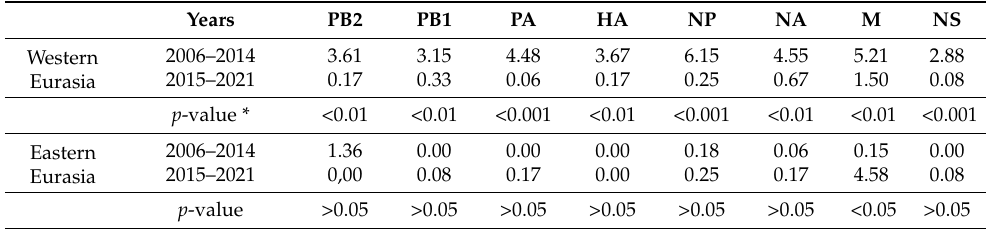
Table 2. Average number of viruses from Western and Eastern Eurasia closely related to each of the Moscow isolates for 2006–2014 and